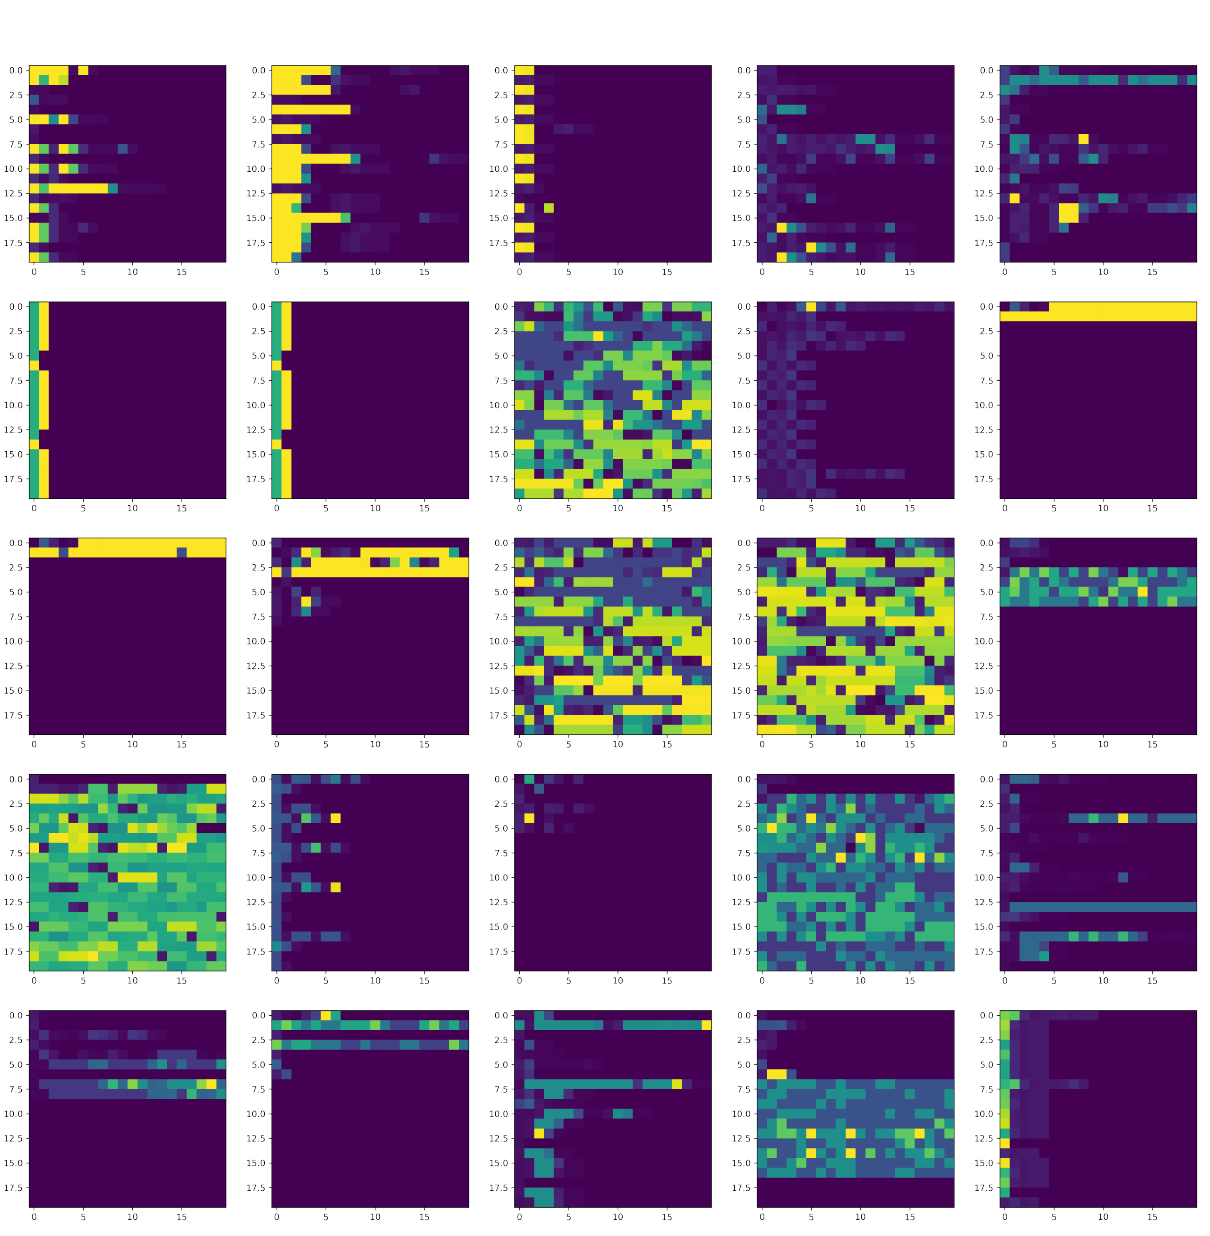
Figure 5. Partial images of surge periods-based original features extracted from network sessions. Table 2. The optimal parameter settings in our